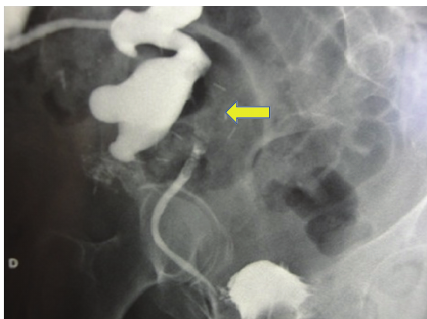
Figure 1: Antegrade pyelography showing a big filling defect in the kidney allograft secondary to a pelvis mass with moderate